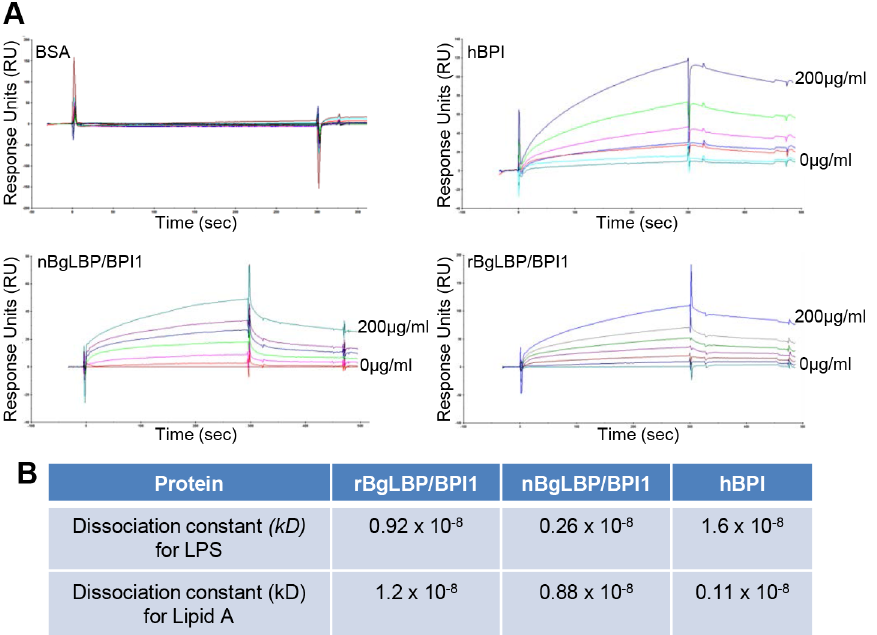
Figure 2. BgLBP/BPI1 bind to LPS and lipid A. (A) Representative plasmon resonance sensorgrams showing the interactions of BSA (negative control), hBPI (positive control), nBgLBP/BPI1 and rBgLBP/BPI1 with LPS. Purified proteins were immobilized on a CM5 sensor chip and serial LPS dilutions (5, 10, 25, 50, 100 and 200 m g/ml) were injected at a flow rate of 50 ul/min. The responses in RU were recorded as a function of time. Data were fitted to a 1:1 Langmuir binding model. Similar sensorgrams were obtained with lipid A. (B) Dissociation constants ( kD ) calculated for each protein.